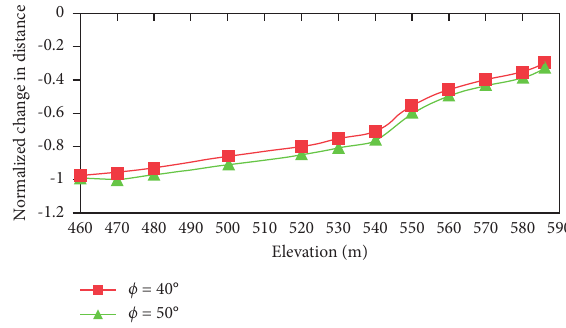
Figure 17: Normalized change in distance calculated from SSR simulation